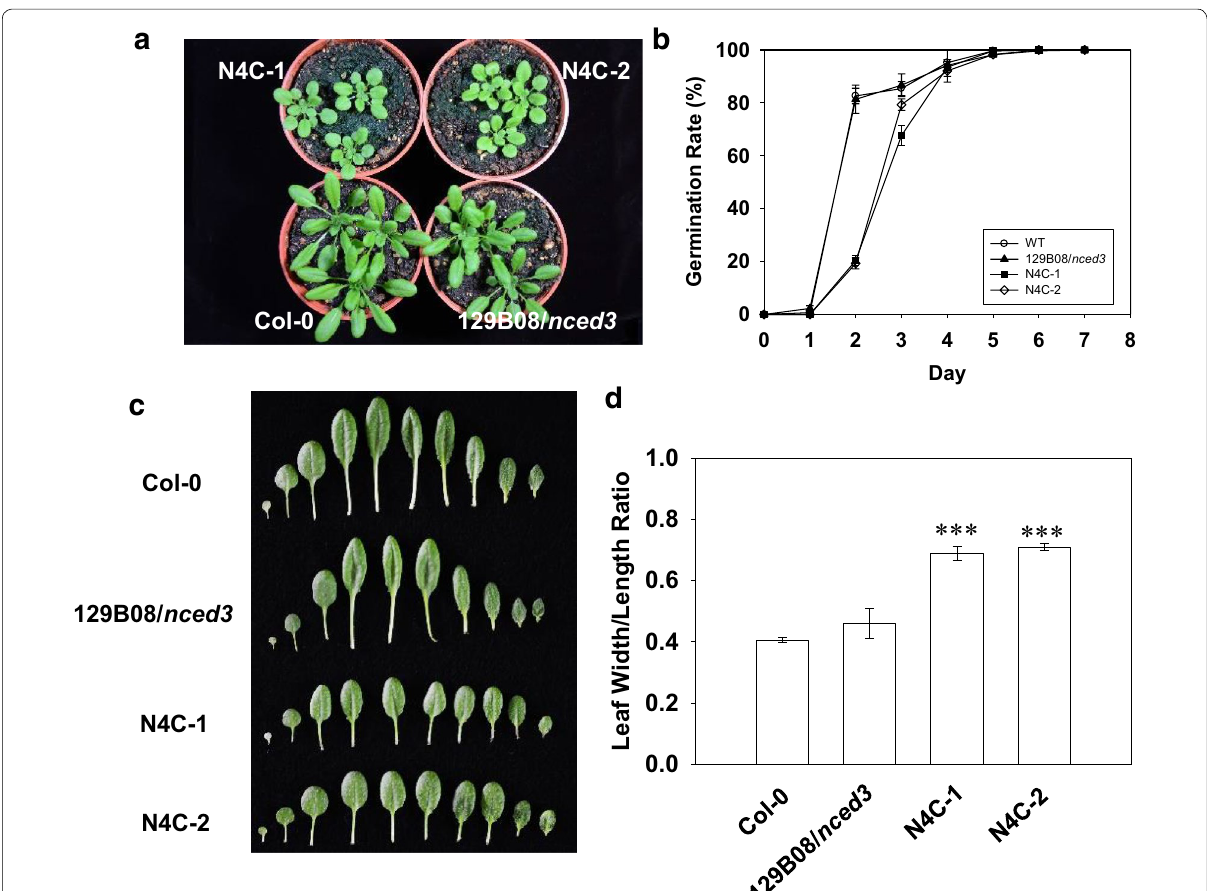
Fig. 2 Phenotypic comparison of 35‑day‑old, soil‑grown Col‑0, 129B08/ nced3 mutant, and two OsNCED4 ‑overexpressing transgenic lines. a Above‑ground plant phenotype. b Germination rate, calculated from 100 seeds for each line, with mean c Leaf shape. d Width‑to‑length ratio of the fifth leaf. In d , the values are the mean *** P < 0.001, Student’s t